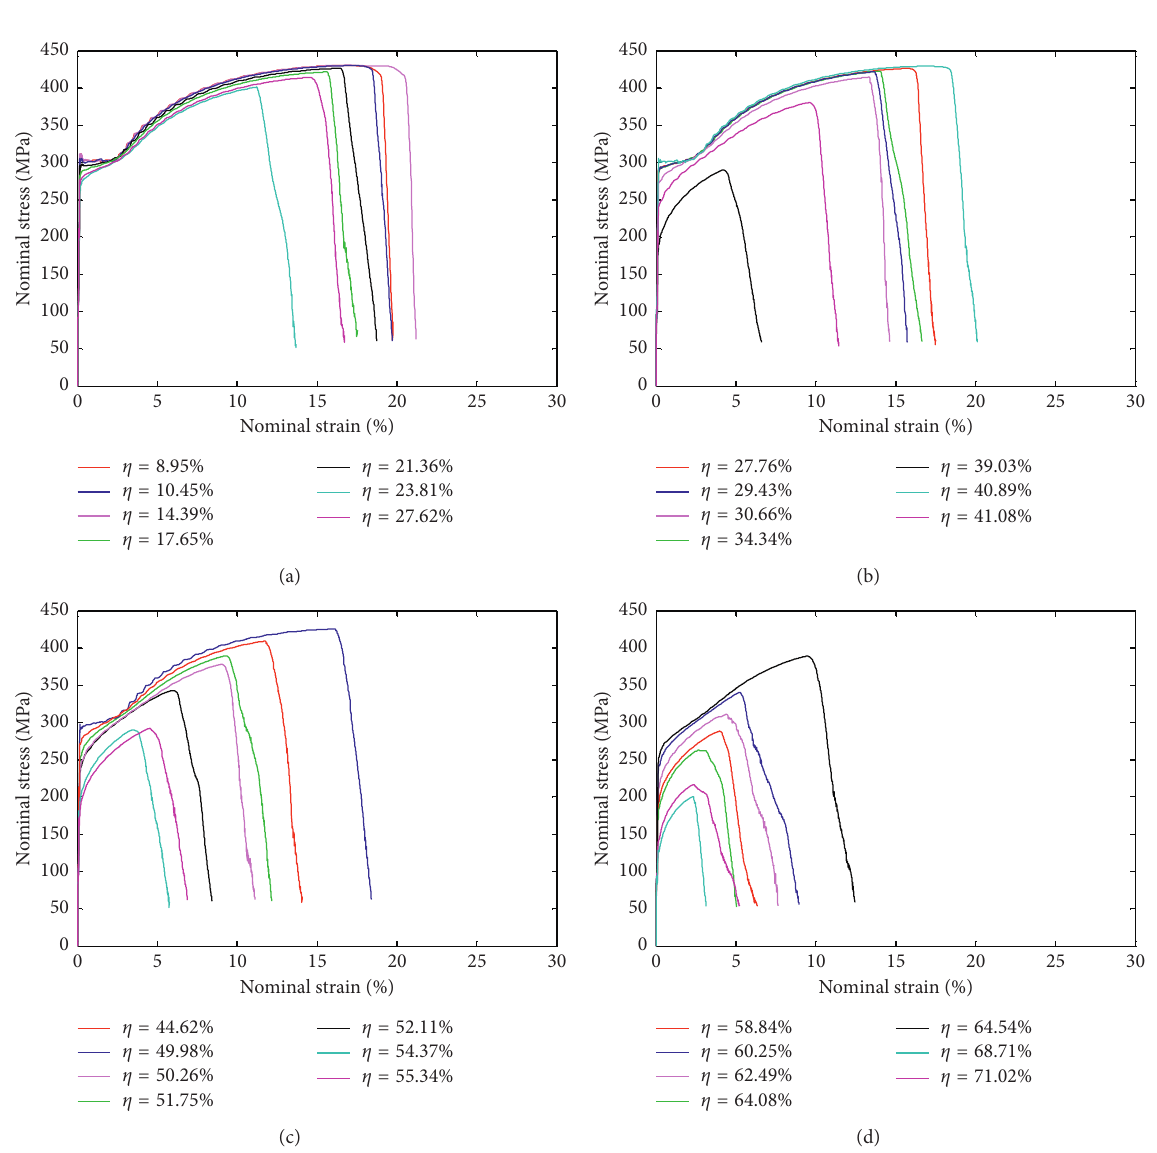
Figure 12: Calculating the nominal stress-strain curve for corroded specimens using equation